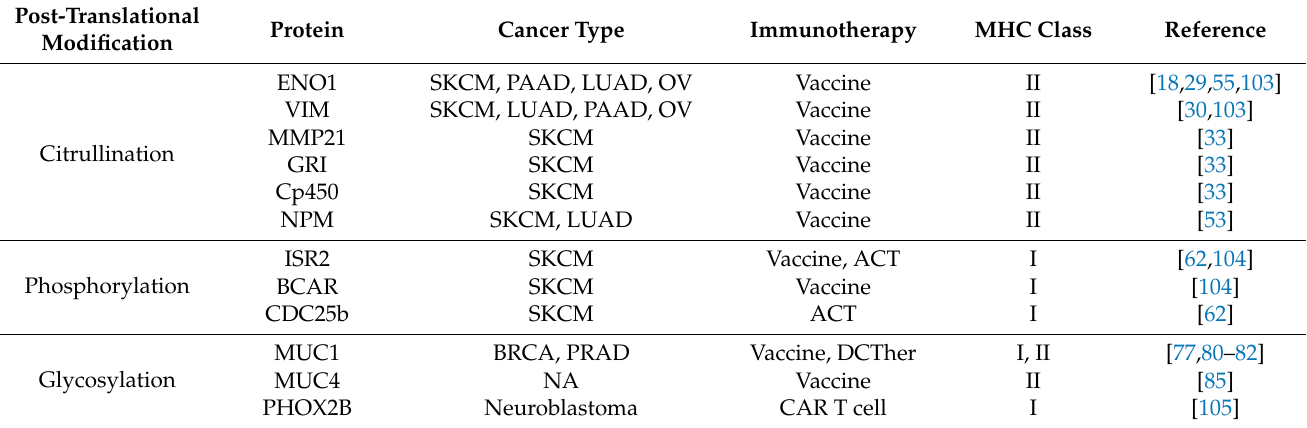
Table 1. Summary of the post-translational modified peptides used in